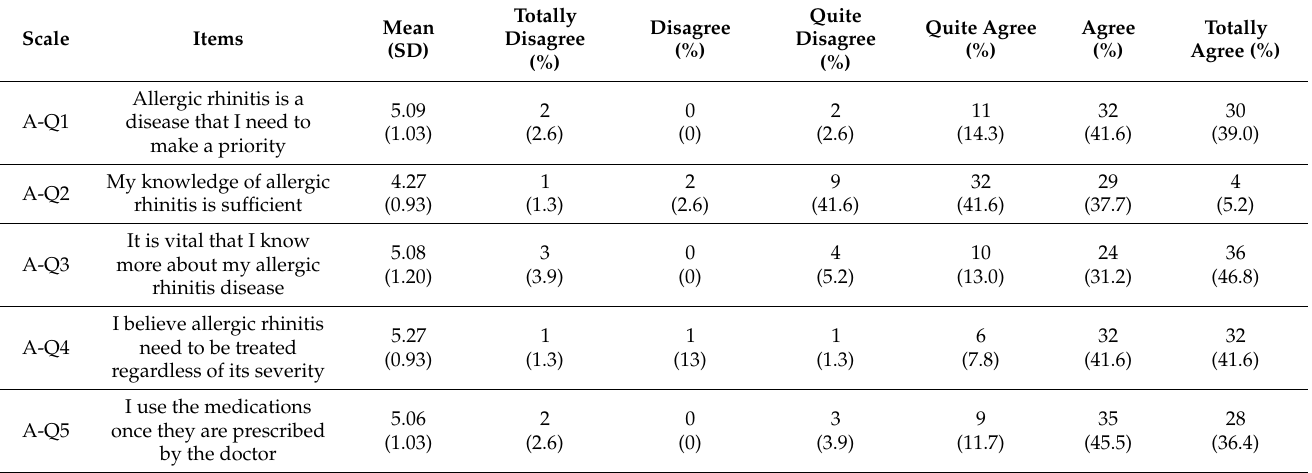
Table 4. Descriptive statistics of the items in the attitude domain.